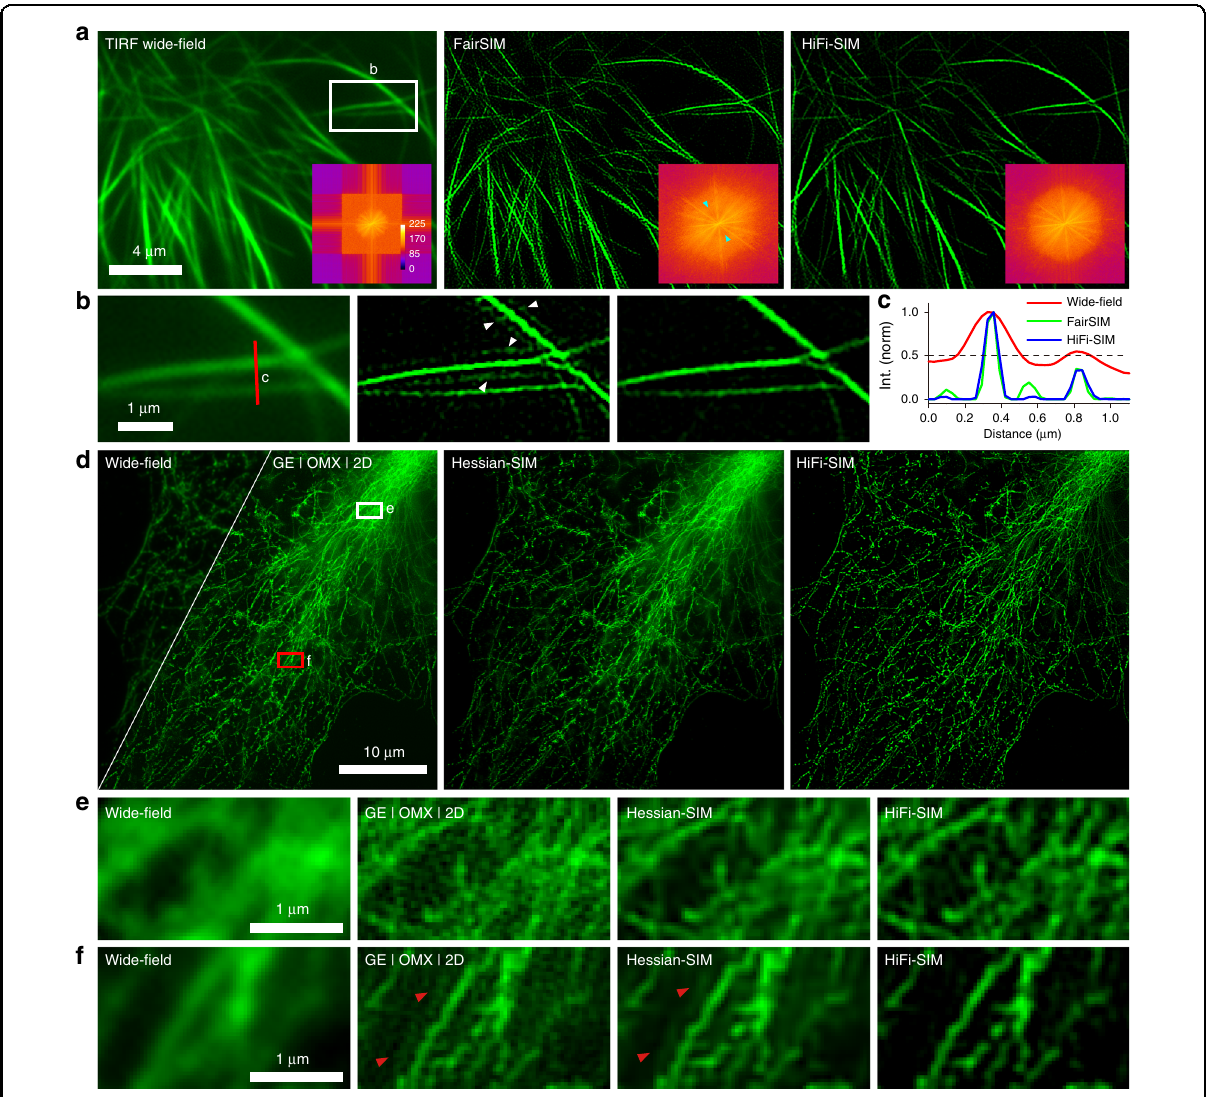
Fig. 4 Performance of HiFi-SIM on reconstructing raw data with high-quality. a TIRF wide- fi eld image of microtubules in live COS-7 cells is shown in the left, and the SR images of fairSIM and HiFi-SIM are presented in the middle and right, respectively. Lower-right corner shows corresponding reconstructed spectrum. b Magni fi ed images of the white-box region in a . c Intensity pro fi les along the red line in b . d Equivalent wide- fi eld image of microtubules in fi xed COS-7 cells is shown in the left triangle, and the SR images were reconstructed using GE SoftWoRx, Hessian- SIM, and HiFi-SIM, respectively. e , f Magni fi ed images of the wide- fi eld equivalent in the white-box and red-box regions in d are shown in the left, and the corresponding SR images were reconstructed by SoftWoRx, Hessian-SIM, and HiFi-SIM, respectively. Here, Hessian-SIM uses the same OTF as used in fairSIM (Fig. S11), and uses the built-in notch fi lters to suppress pattern artifacts ( a 0 = 0.05, v =